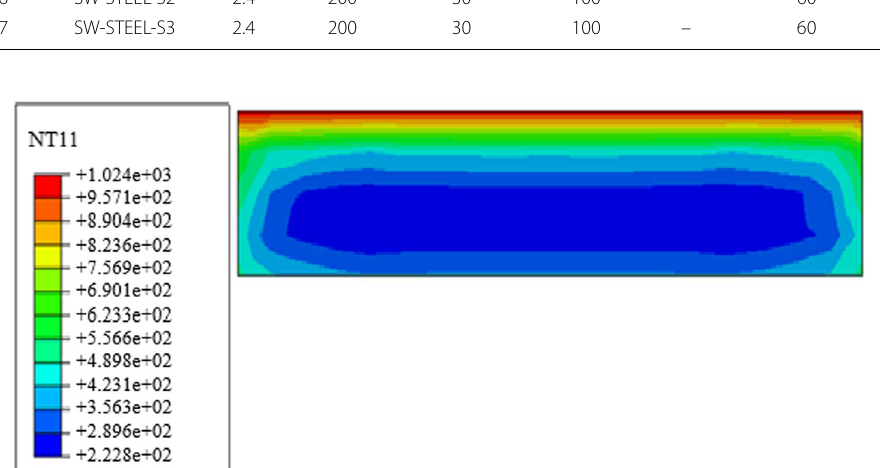
Fig. 30 Temperature distribution across the cross section of the shear